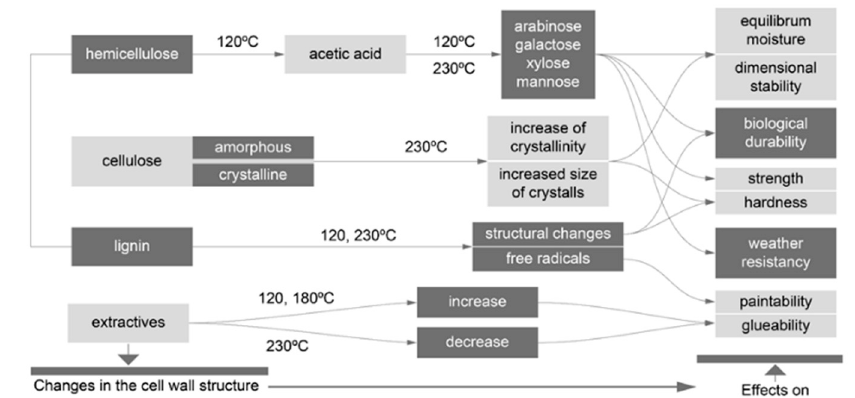
Figure 1. Chemical changes that occur during thermal modification (adapted from the International Table 2003 [25]).